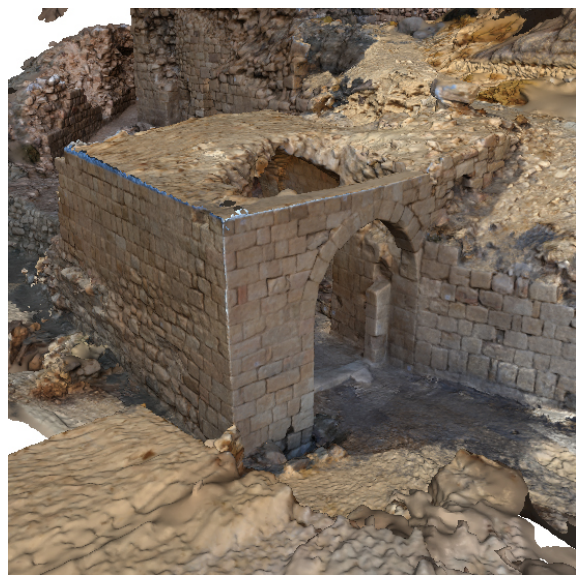
Figure 1. High resolution photogrammetric survey used to extract relevant archaeological